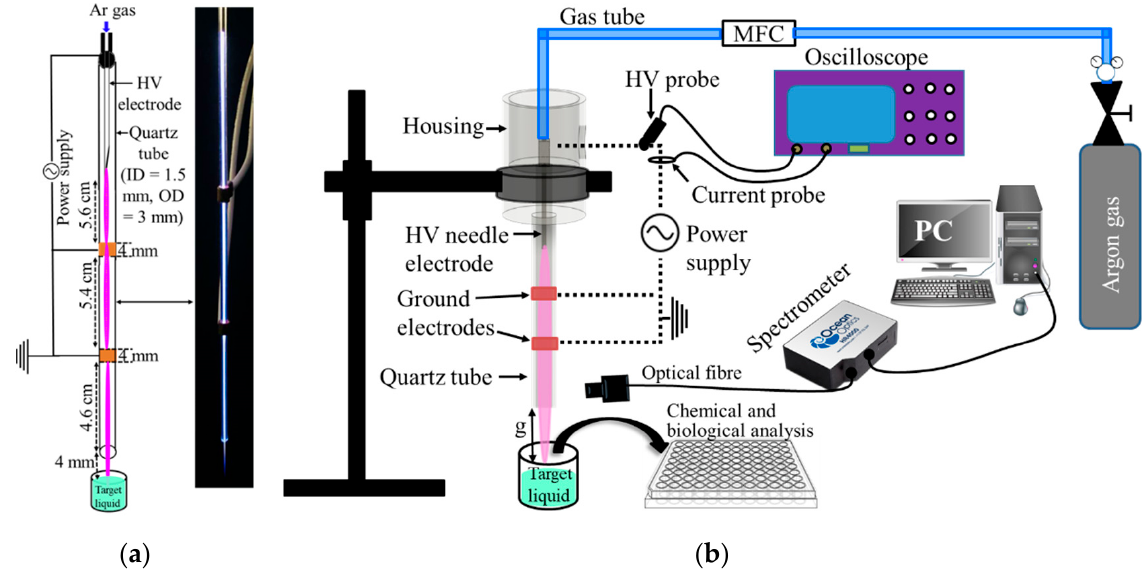
Figure 1. ( a ) Schematic and photograph of the plasma jet system used for the activation of acetyl donors; ( b ) schematic of the overall experimental setup.